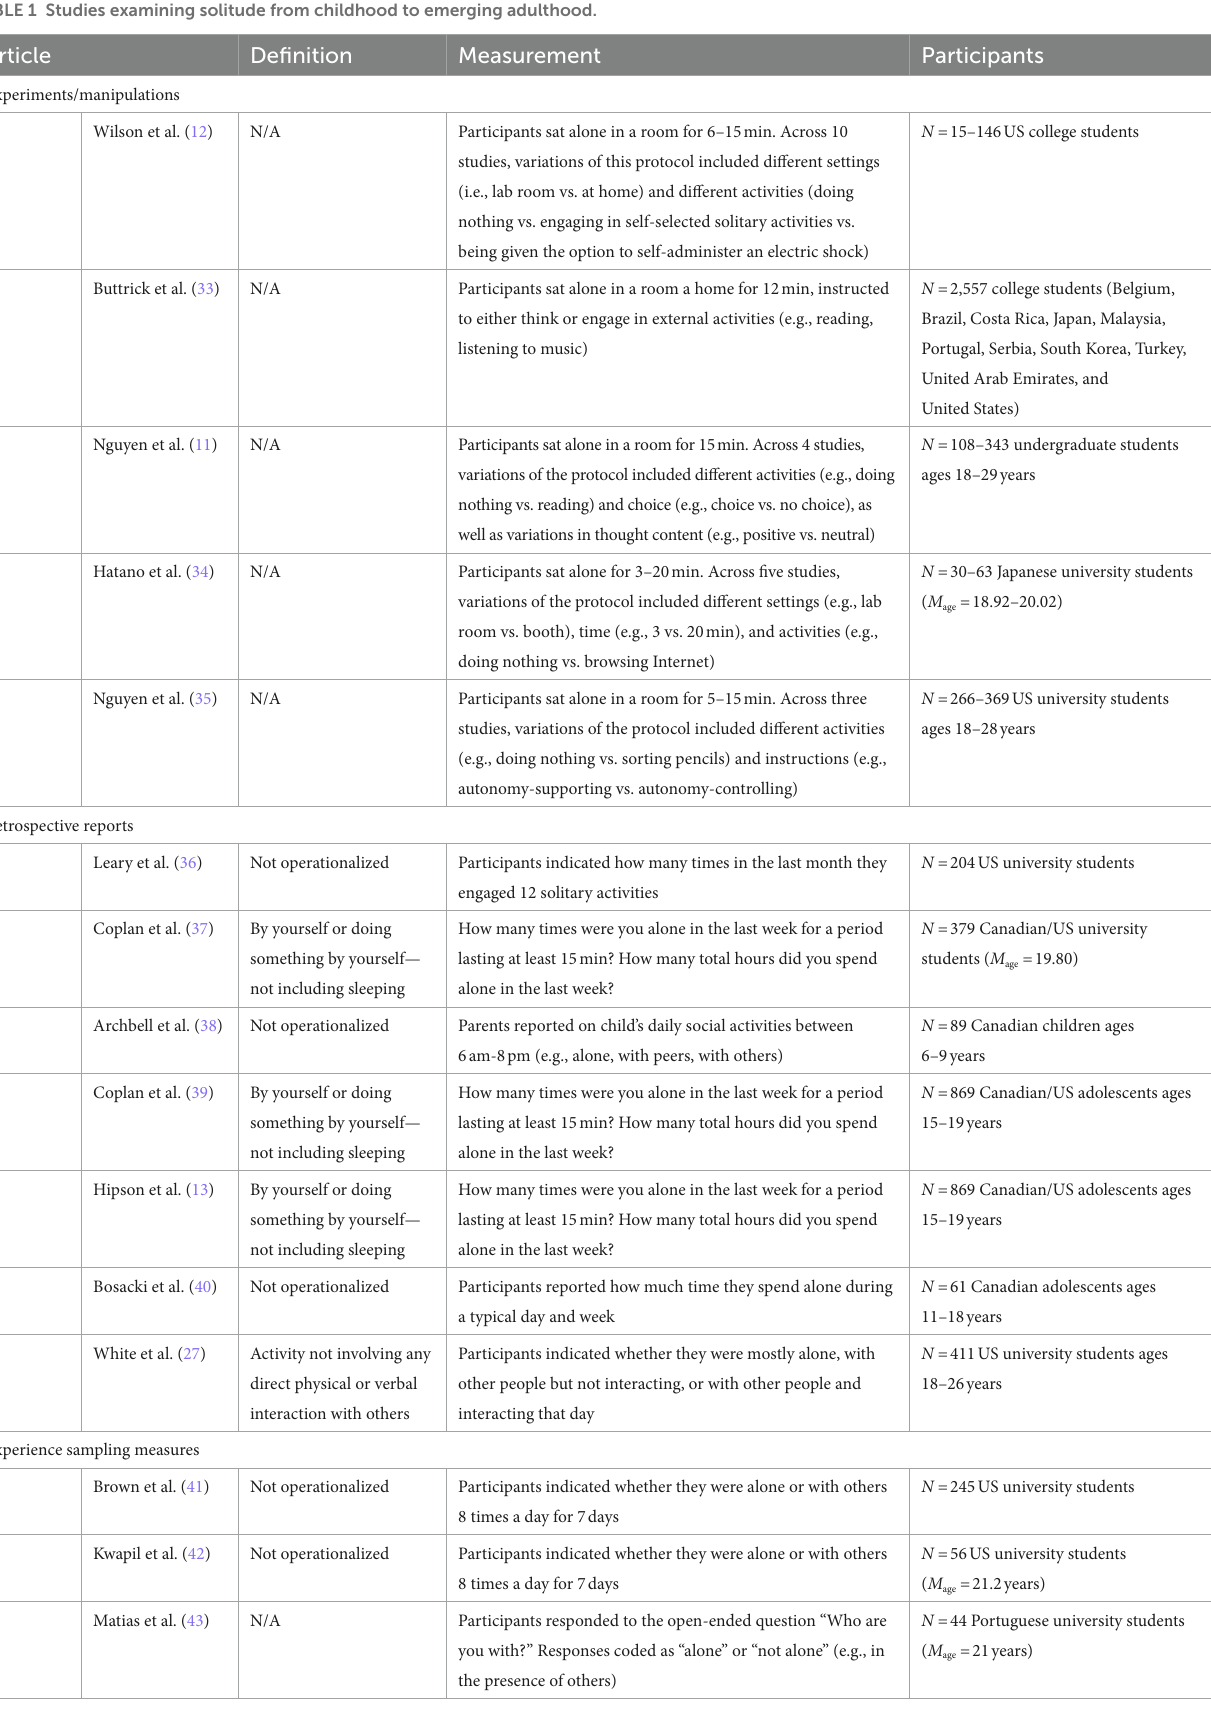
TABLE 1 Studies examining solitude from childhood to emerging